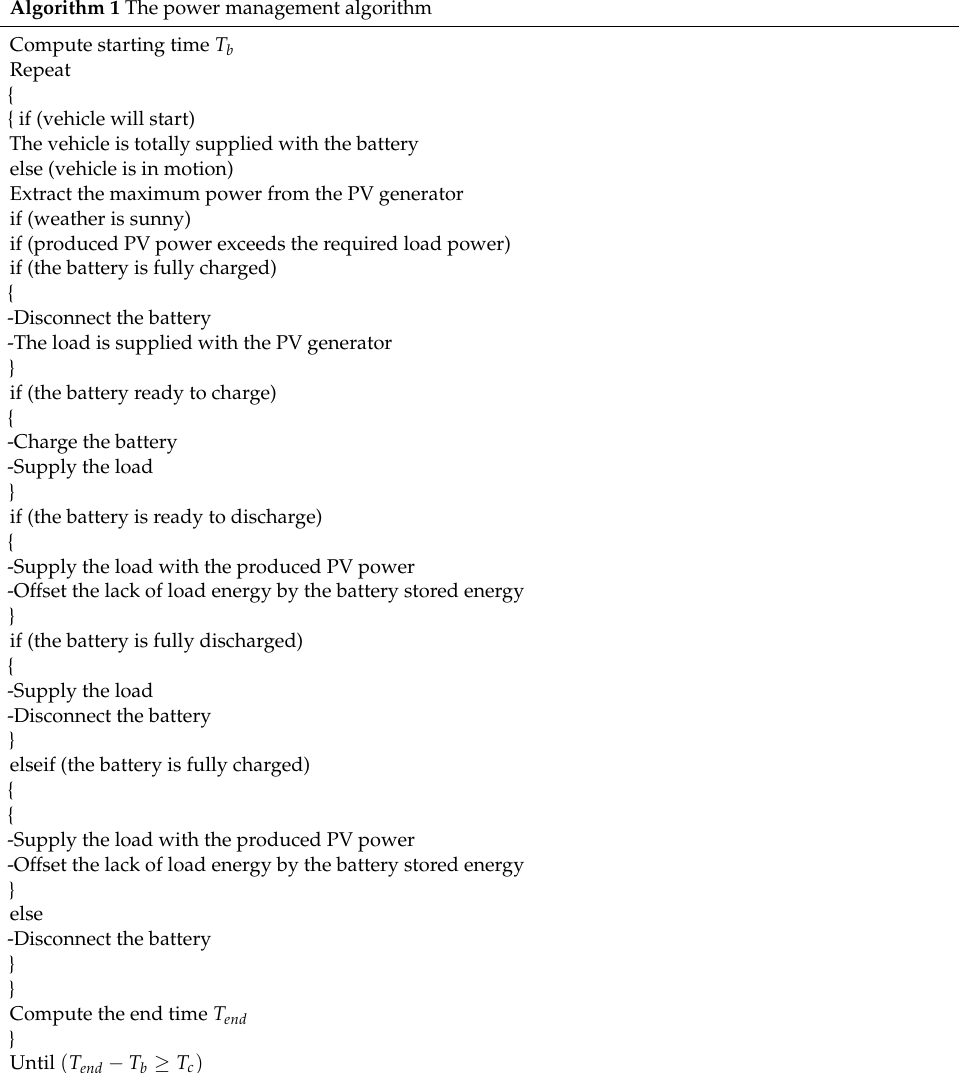
Algorithm 1 The power management